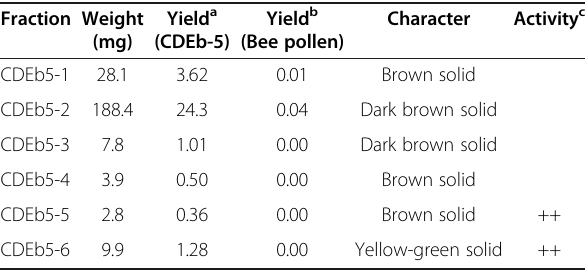
Table 5 The weight and character of the pooled active fractions derived from the Sephadex LH-20 size exclusion chromatography of the bee pollen derived